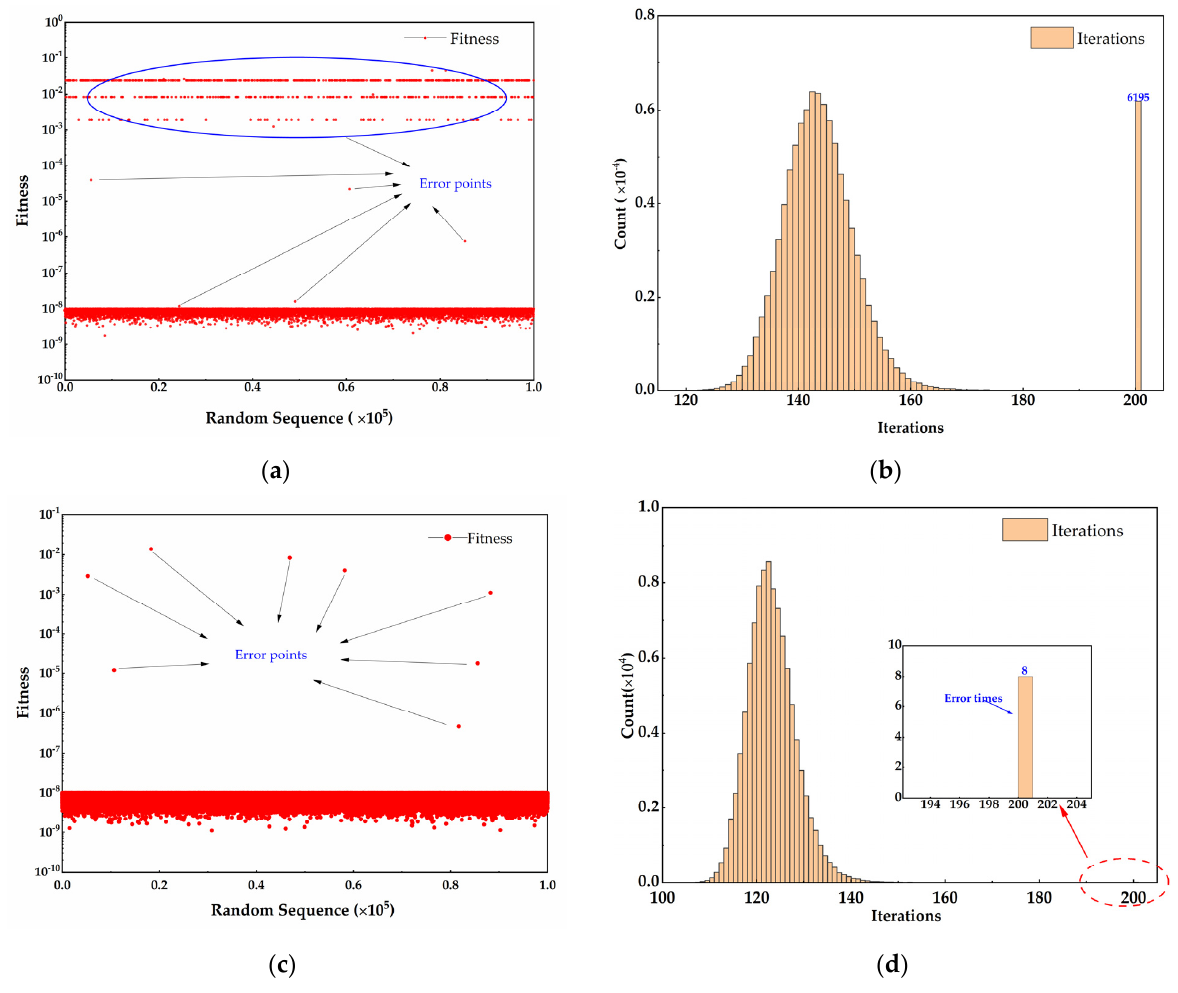
Figure 9. The fitness results and the iterations of the whole workspace postures. ( a ) Fitness of PSO soling results for workspace sampling. ( b ) Histogram of PSO iterations. ( c ) Fitness of SA–PSO solving results for workspace sampling. ( d ) Histogram of SA–PSO iterations.